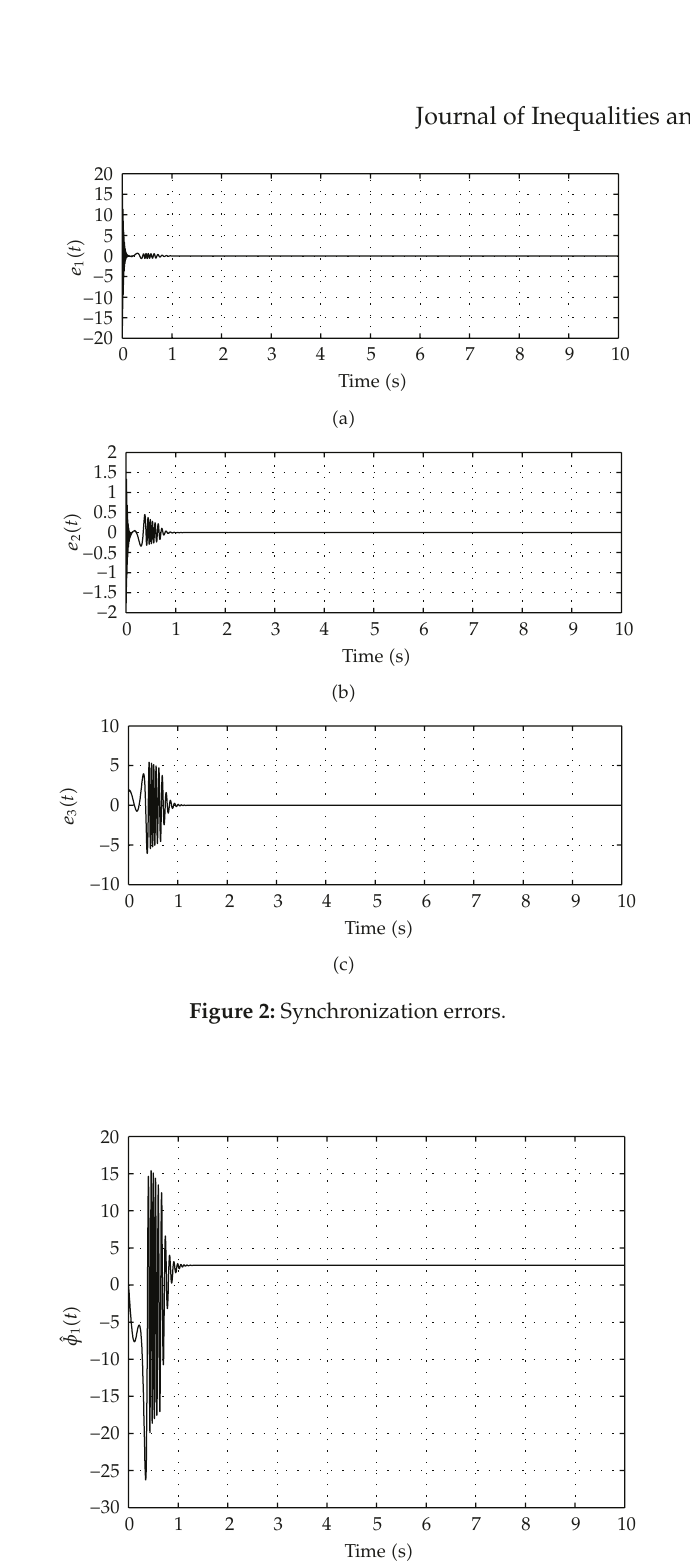
Figure 3: The estimate value